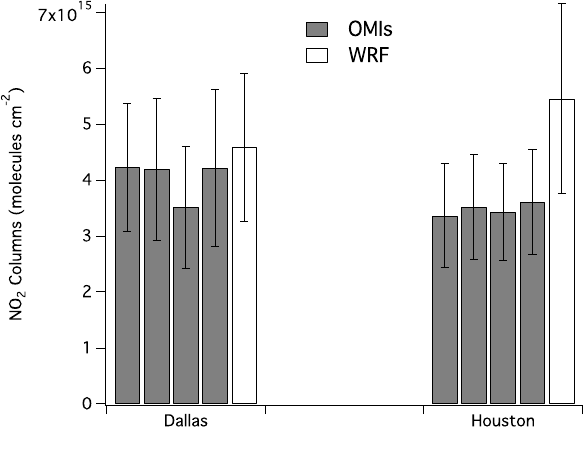
Fig. 6. OMI (U. of Bremen, two KNMI, and NASA products) and Figure 6. OMI (U. of Bremen, two KNMI, and NASA products) and model NO 2 columns for the 2 model NO 2 columns for the Dallas and Houston boxes. Filled (un- filled) bar represents OMI (WRF-Chem model) columns. Temporal Dallas and Houston boxes. Filled (unfilled) bar represents OMI (WRF-Chem model) columns. 3 variability (standard deviation) of columns is shown as error Temporal variability (standard deviation) of columns is shown as error bars. The data for July 26, 4 2006 – October 6, 2006 are used. 5